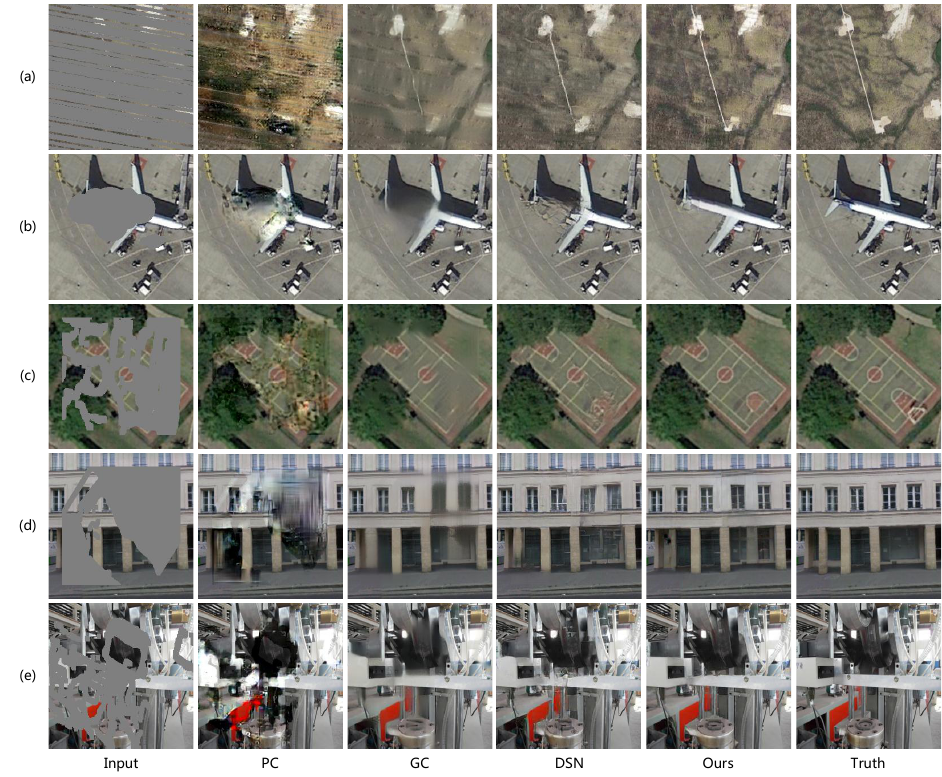
Figure 1. Example results from different inpainting methods, including PC [8], GC [9], DSN [10], and ours. ( a ) Results of PatternNet [11] with simulated dead pixels, ( b ) results of PatternNet with simulated cloud obscuration, ( c ) results of PatternNet with irregular corrupted regions, ( d ) results of Paris StreetView [12] with irregular corrupted regions, and ( e ) results of Places2 [13] with irregular corrupted